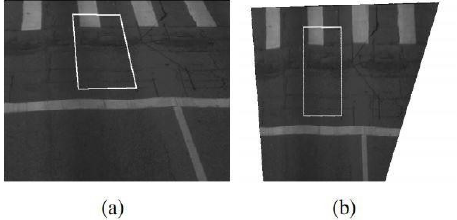
Fig.13: Image improvement: Original image with perspective result; Improved Image